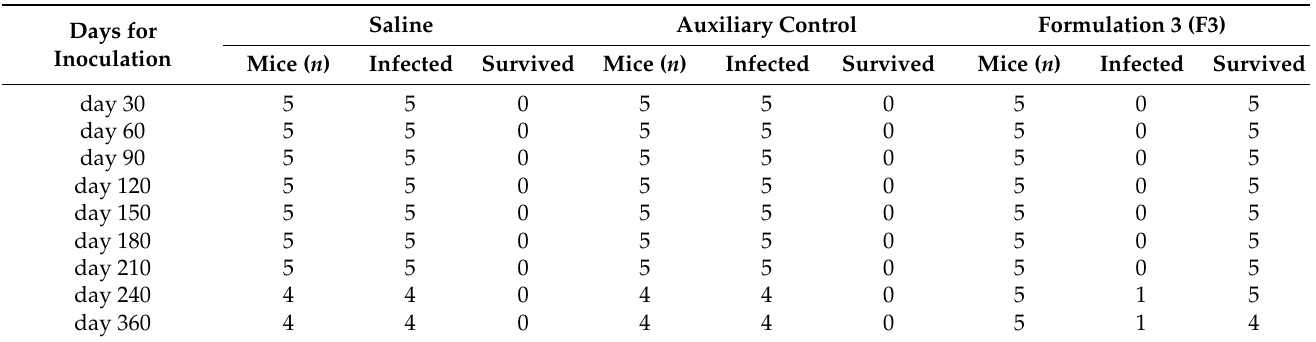
Note: F2 suspended in saline, vehicle (F8) suspended in saline, and saline alone, given to mice by IM. Mice in each treatment group were then divided into subgroups for inoculation of P.b . SPZ. The inoculation was arranged according to the duration of drug placement (see the table). Parasitemia rates and survival rates were summarized 6 days and 30 days, respectively, after the